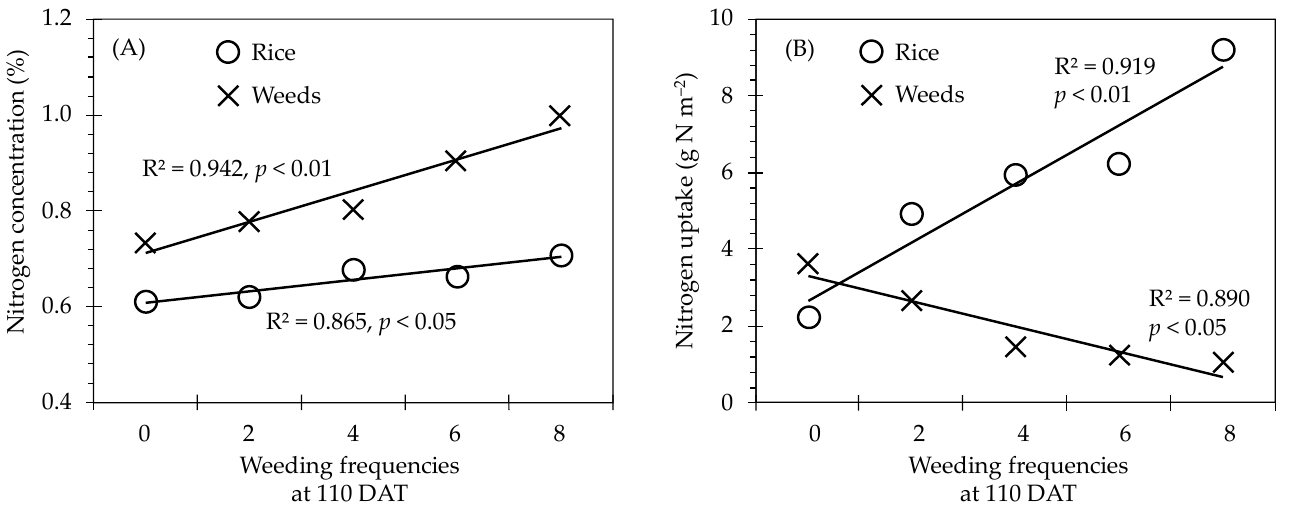
Figure 5. Correlation between weeding frequencies and ( A ) nitrogen concentration or ( B ) nitrogen uptake of rice and weeds at 110 DAT (days after transplantation). The frequency of mechanical weeding until 49 DAT was 0, 2, 4, 6, and 8 times.